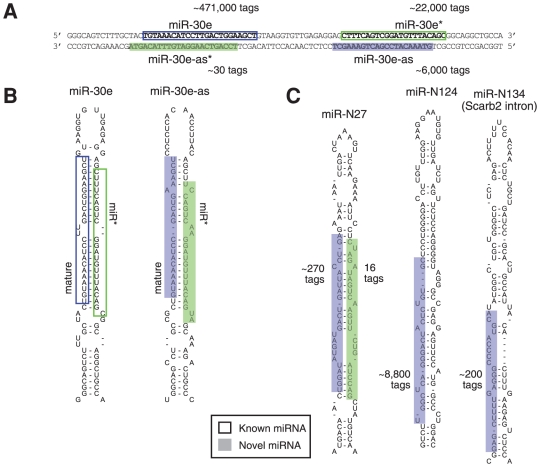
miRNAs candidates deriving from novel precursors and genomic locations in HL-1 cells.(A) The miR-30e locus appears to be expressed bi-directionally, giving rise to miRNAs tags sets mapping to both, the sense (known) and antisense strands (novel; suffix –as denotes antisense-derived miRNA). (B) Predicted structures for both sense and antisense miR-30e hairpin precursors. (C) Examples of tag sets mapping to entirely new candidate miRNA loci in the murine genome. These miRNA species are tentatively named miR-N.. (N for novel). Predicted hairpin structures (RNALfold) of surrounding sequence is shown.